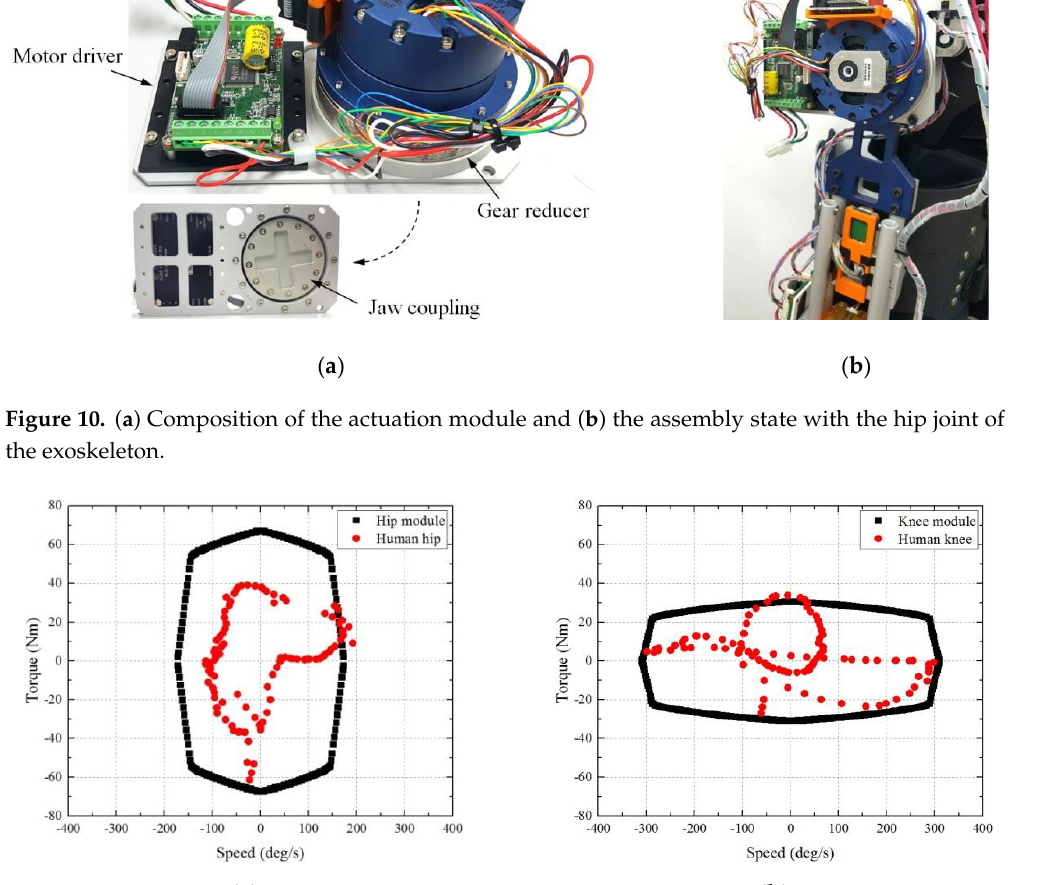
Figure 12. Configuration of the five modes of the exoskeleton according to the assembly of the actuation modules. The blue-circle and red-cross indicates whether the actuation module is assembled to the joint or not, respectively. Each mode of the exoskeleton can be used for the purpose of assisting ( a ) hip and knee joints of both legs; ( b ) hip or knee joints of both legs; ( c ) hip and knee joints of one leg; and ( d ) one of the joint of lower-limb. In the case of ( e ) mode 0, although it cannot assist the joints of a wearer by using actuation modules, it can be used to measure the motion of a wearer by using embedded sensors. 2.2. Strategy for Terrain Feature Estimation This study calculated the position of the contact points on the ground at each step while the wearer walked; the slope and elevation of the terrain were estimated by modeling the contact points as a spatial plane. The proposed method calculated the position and orientation of each segment and foot through kinematic data derived from the embedded sensors. Simultaneously, we used the plantar pressure, which was measured by the insole sensor, to calculate the CoP and utilized it as a contact point with the ground. This was then introduced into the previously performed kinematic analysis, and the spatial locations of the contact points were collected while walking. The collected contact points on the ground on which the exoskeleton stepped were modeled as a plane through the least-square method. Finally, we used the normal vectors of the modeled planes during each step to estimate the terrain features, namely the slope and elevation. 2.2.1. Kinematic Analysis of Lower Limb Exoskeleton